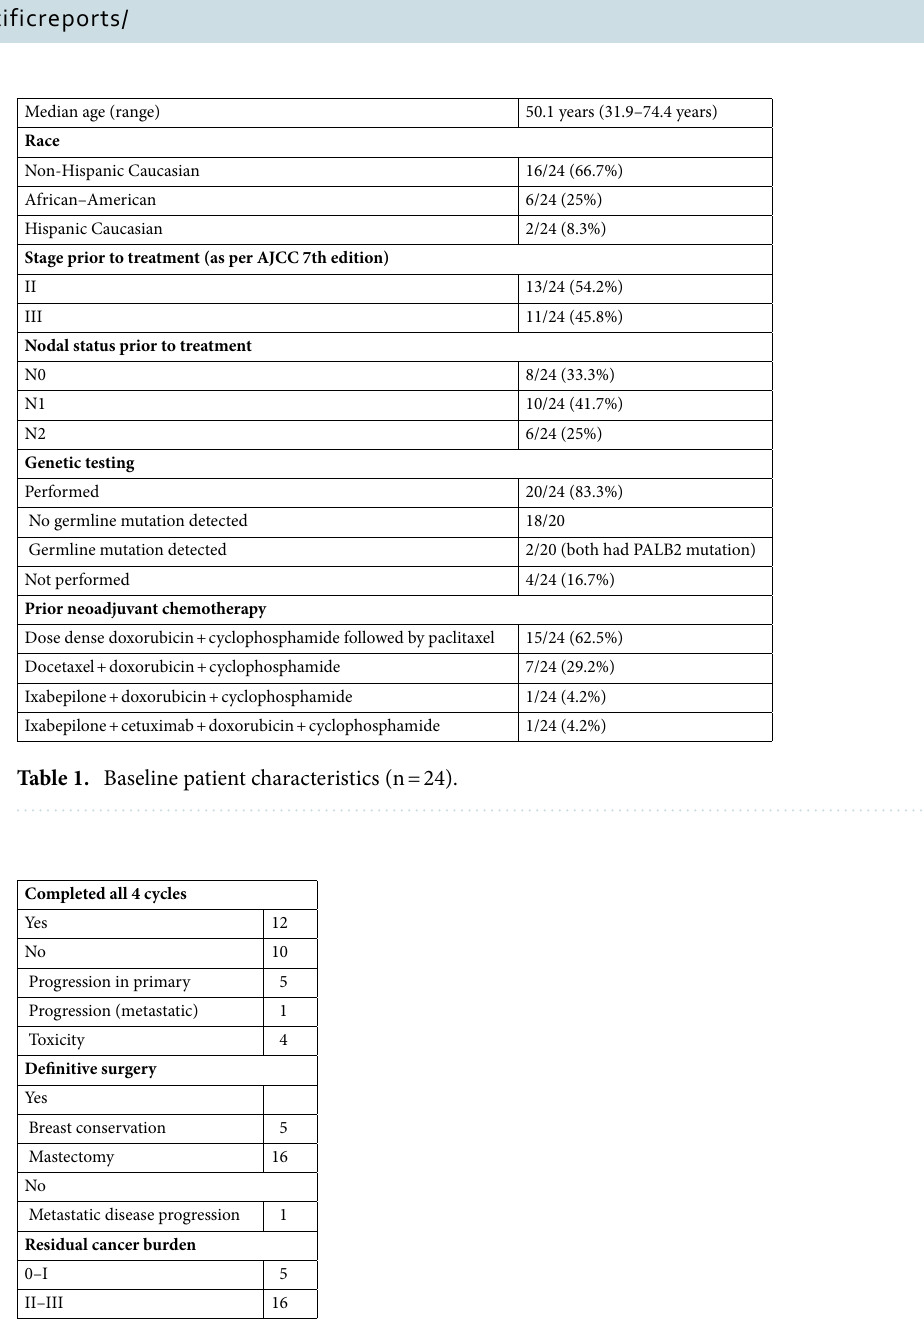
Table 2. Treatment response for patients available for analysis (n =